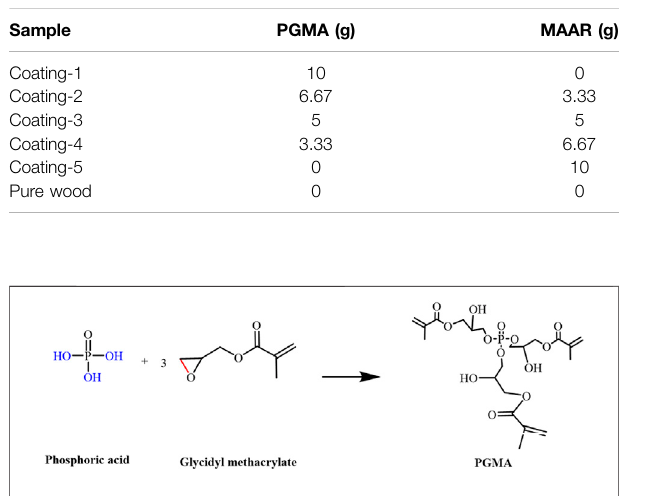
FIGURE 2 | The synthesize route of